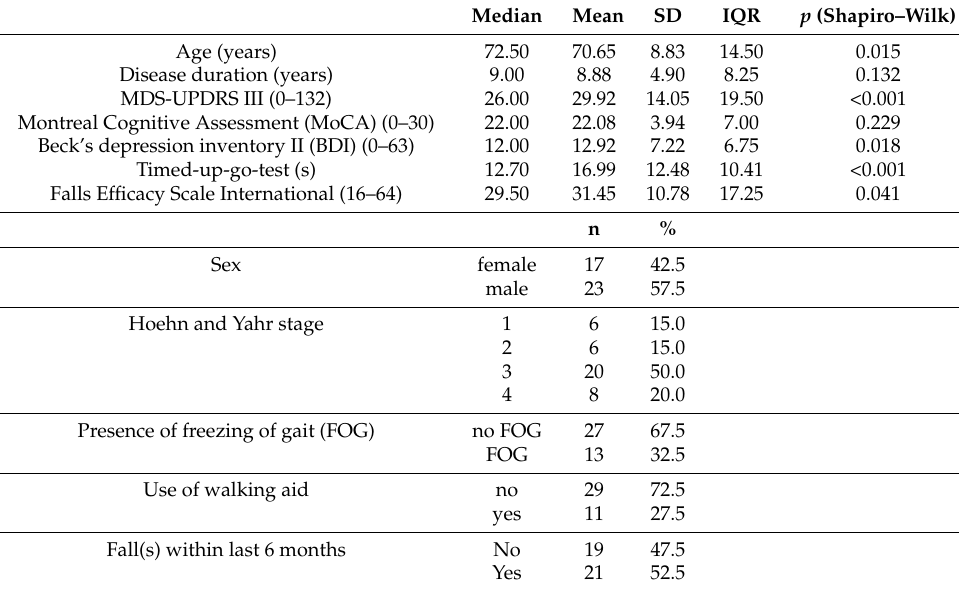
Table 1. Demographical and clinical